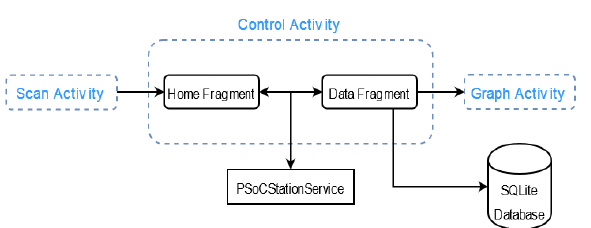
Figure 7. Architecture of the developed Android